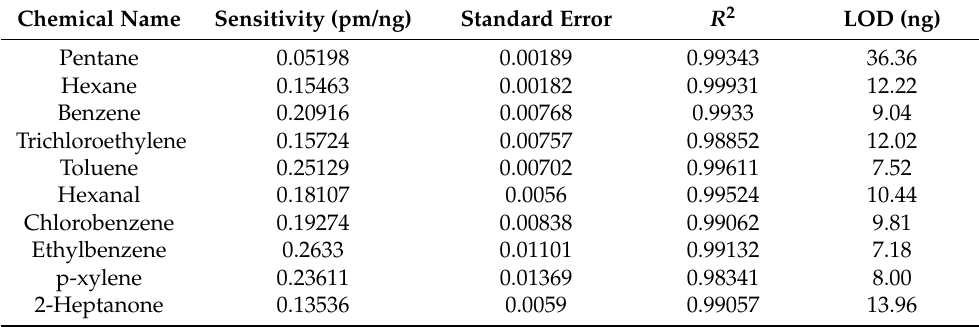
Table 2. Sensitivity and detection limit characterization for a panel of 10 VOCs.